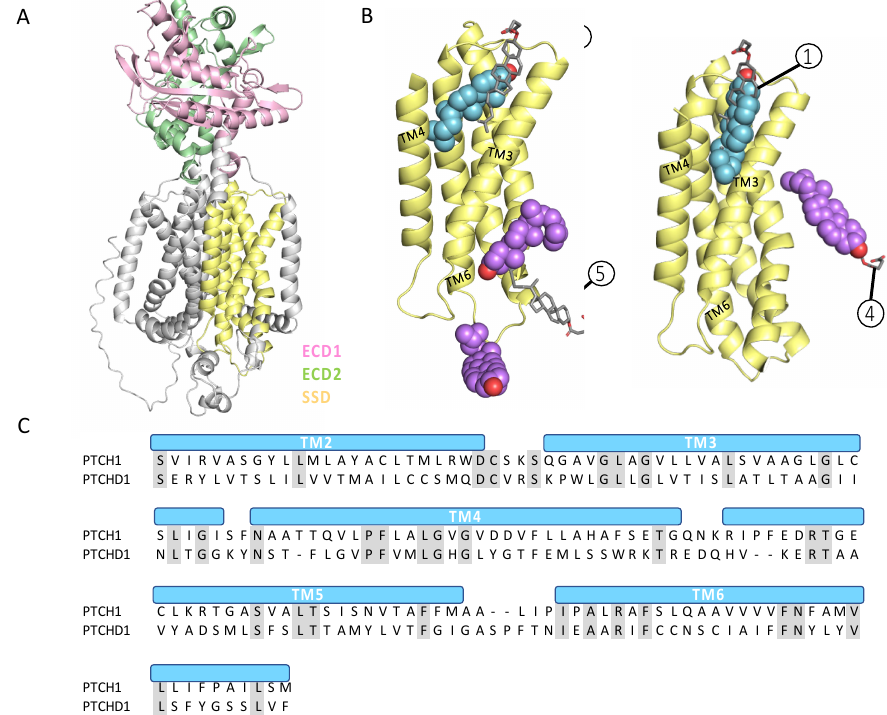
Figure 5. Cholesterol docking to PTCHD1. ( A ) PTCHD1 (AF-Q96NR3) consists of two ECDs (pink and green), and 12 transmembrane helices, five of which form the SSD (yellow). ( B ) Cholesterols docked to PTCHD1 SSD (left, AF-Q96NR3) aligning well with PTCH1 (6RMG) cholesterol-binding sites 1 and 5 (superposed PTCH1 cholesterols in grey). Cholesterols docked to the AlphaFold2-predicted PTCH1 SSD (right, AF-Q13635), right, and align with experimentally determined cholesterol-binding sites 1 and 4 (superposed PTCH1 (6RMG) cholesterols in grey). ( C ) A sequence alignment of PTCH1 and PTCHD1 SSDs.